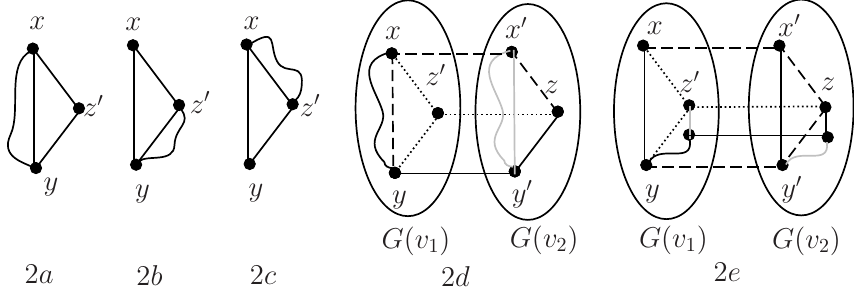
Fig. 2: The edges (or paths) of a tree are shown by the same type of lines. The lightest lines stand for edges (or paths) not contained in T ∗ i